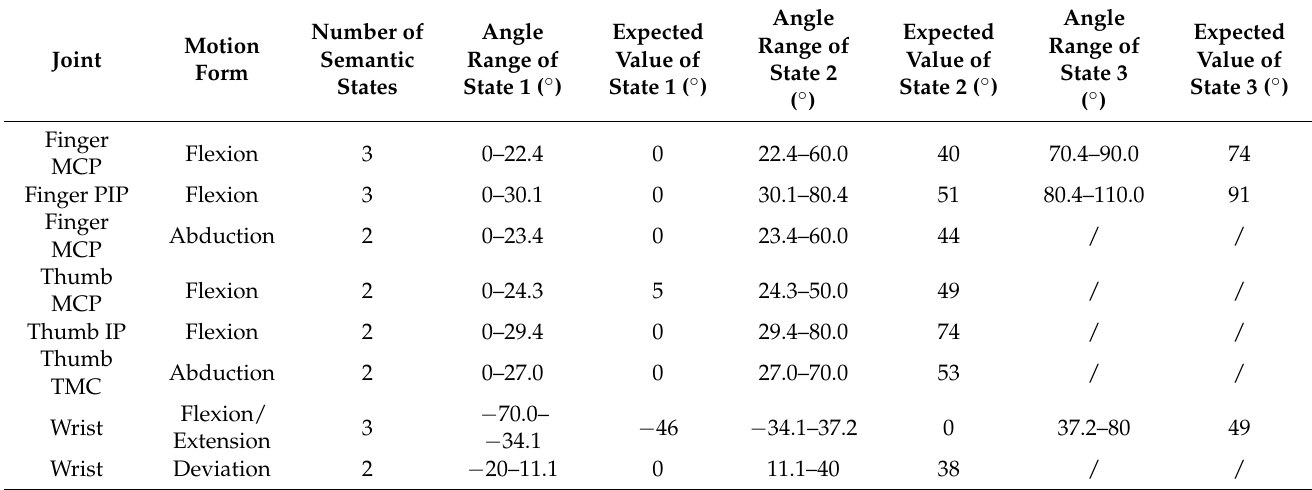
Table 5. Semantic state classification results of each hand motion primitive unit for the real